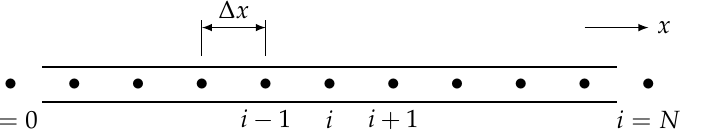
Figure 4. Distribution of equally spaced interpolation points for the finite difference